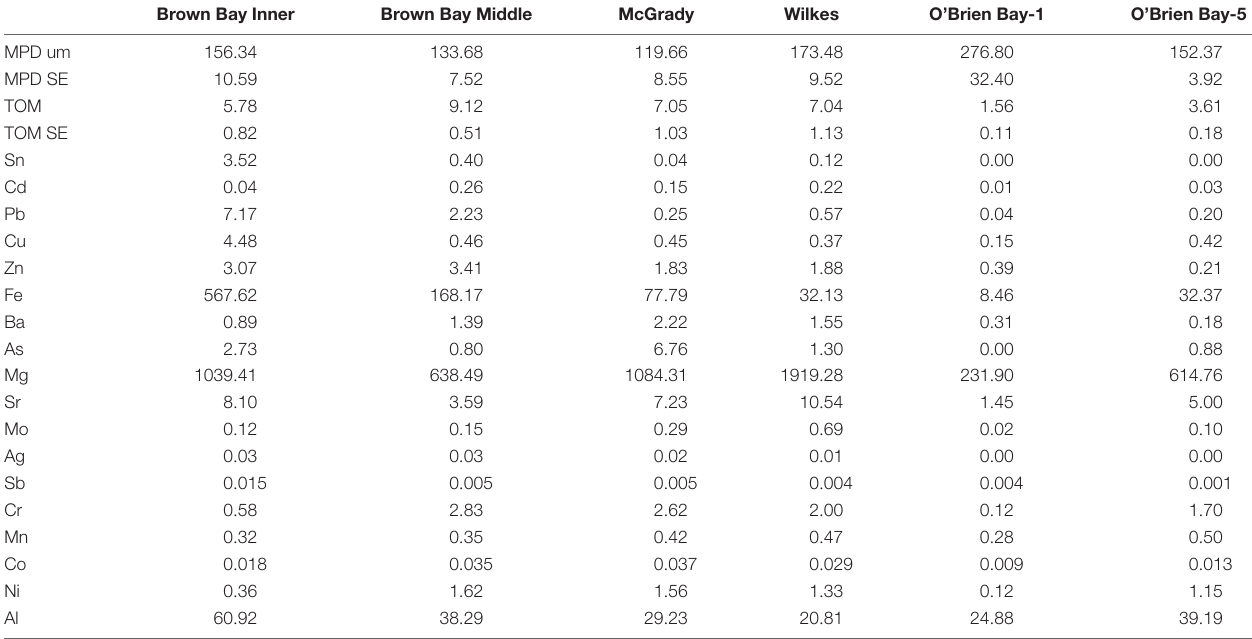
TABLE 6 | Sediment properties at locations used in this study including: MPD = mean particle diameter; SE = standard error; TOM = total organic matter. Brown Bay Inner Brown Bay Middle McGrady Wilkes O’Brien Bay-1 O’Brien